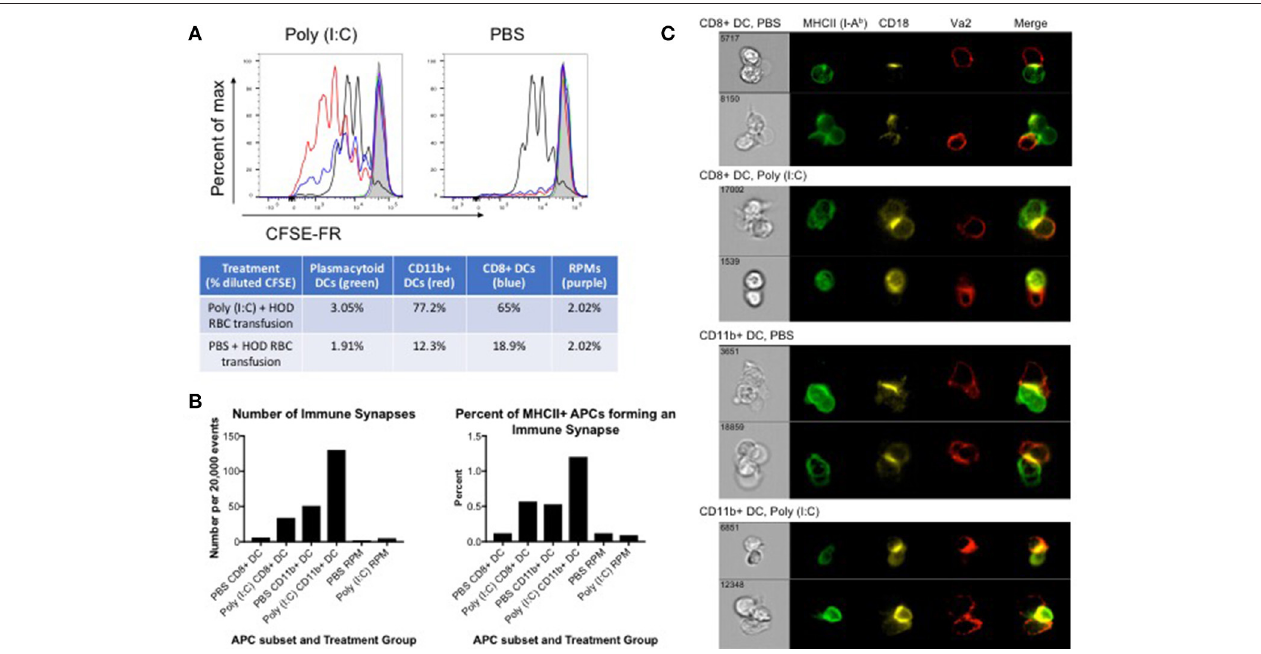
FIGURE 4 | CD8 + and CD11b + DCs promote proliferation and immune synapses with HOD RBC-specific T cells. Recipient B6 mice were treated with 200 ug of poly (I:C) or control PBS and subsequently transfused with 100 uL of leukoreduced, packed, DiO-labeled HOD RBCs. Spleens were harvested 18–24h post transfusion, collagenase digested, and stained with antibodies to delineate individual APC populations. DiO + APCs were sorted and co-cultured at a 10:1 ratio with CD4 enriched OTII T cells labeled with CFSE-FR. (A) Co-cultured cells were harvested after 3 days and CFSE-FR dilution was assessed in Va2 + Vb5.1/5.2 + CD4 + Thy1.1 + OTII T cells. Lines: pDCs (green), CD11b + DCs (red), CD8 + DCs (blue), RPM (purple), PMA/ionomycin (black), and media alone (gray). In separate experiments, co-cultured cells were harvested after 2 days and stained with antibodies to identify APCs, OTII T cells, and the immunological synapse. APCs were identified as MHCII + (I-A b + ) and either CD11c + (for DCs) or F4/80 + (for RPMs) whereas OTIIs were defined as Va2 + CD4 + Thy1.1 + . The immunological synapse was determined by co-expression of Va2, CD4, MHCII, and CD18 (also known as LFA-1). (B) The number and frequency of